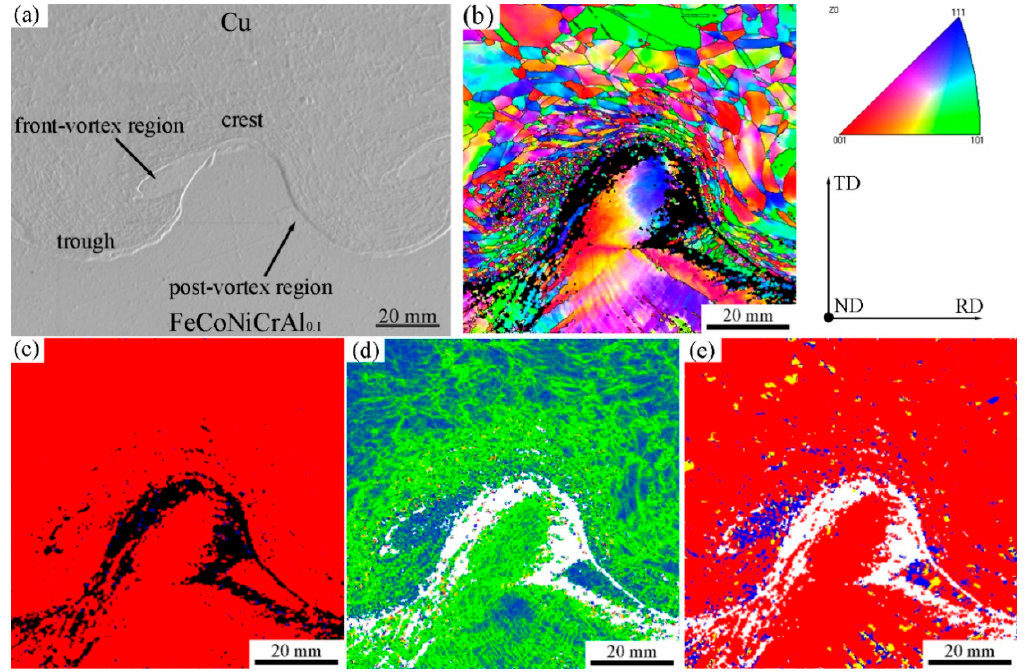
Figure 5. EBSD analysis results of WCH2 at the interface. ( a ) SEM micrograph selected for EBSD testing. ( b ) EBSD inverse pole figure (IPF). ( c ) Phase map of the FCC (red), and BCC (blue). ( d ) Kernel average misorientation image. ( e ) Recrystallization distribution diagram.